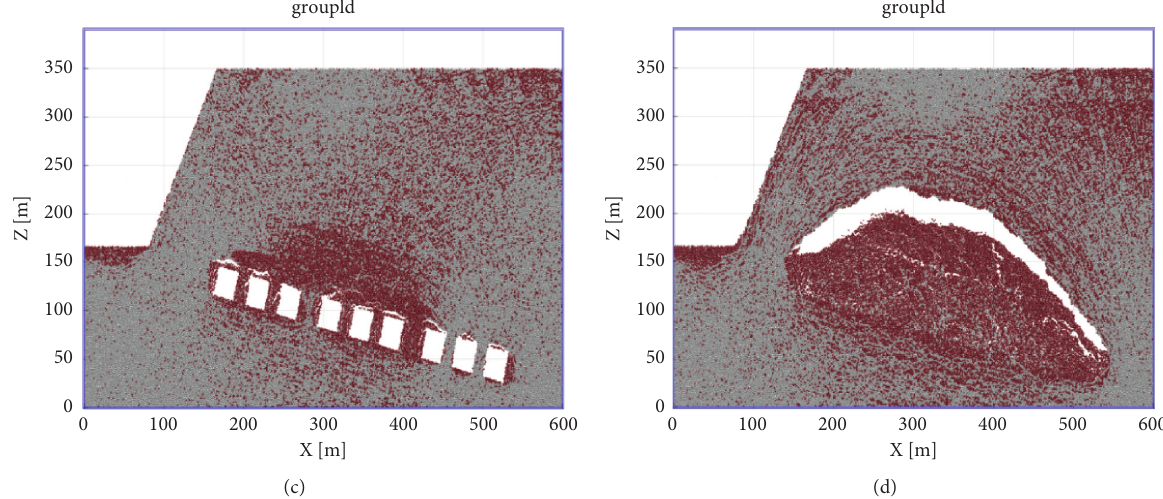
Figure 12: The plastic zone of excavated rock mass in (a) the first stage, (b) the second stage, (c) the third stage, and (d) the stoping